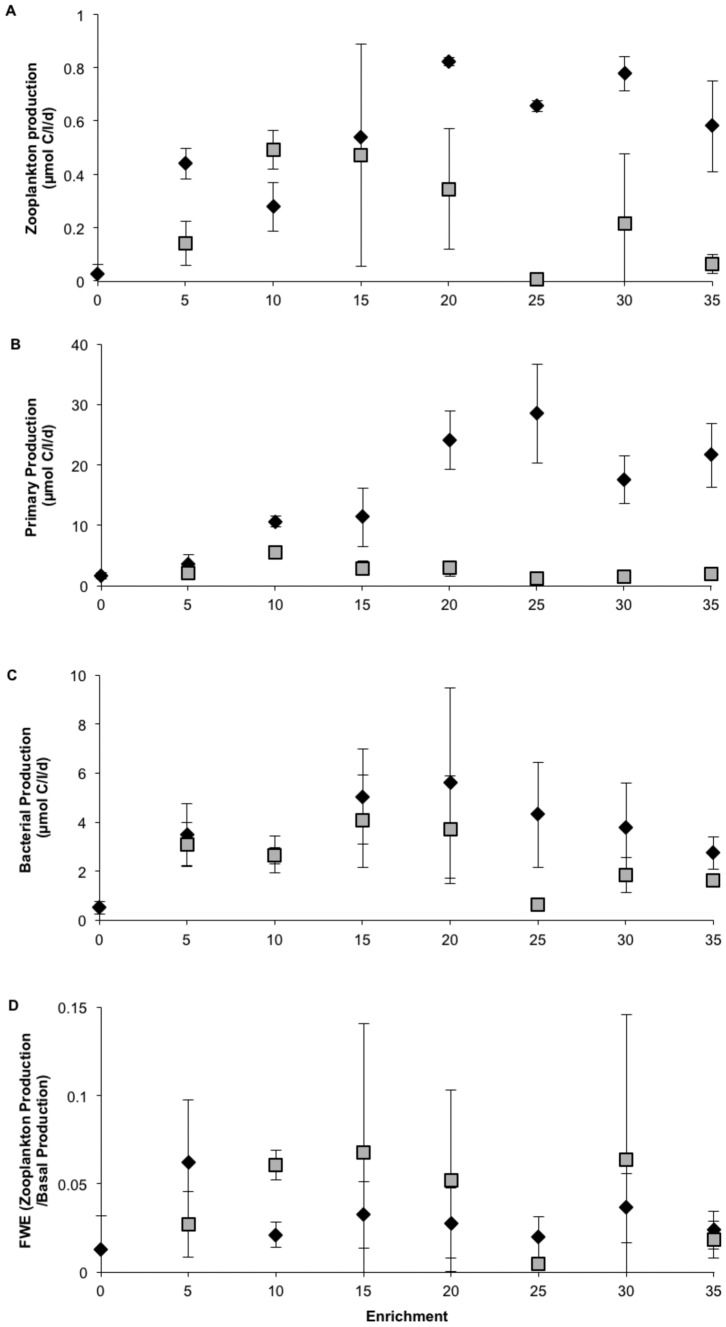
Production rates of mesozooplankton (a), phytoplankton (b) and bacteria (c) for NP (⧫) and CNP (▪) treatments sampled during the two last weeks of the mesocosm experiment.Food web efficiency is presented in panel d. Error bars are standard error (n = 2).